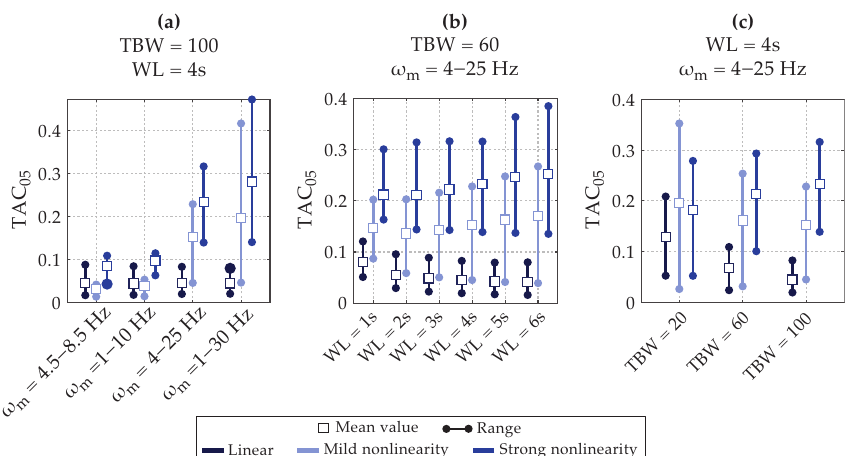
Figure A1. Influence of three hyper-parameters in the derivation of TAC (wavelet time-bandwidth parameter of the Morse wavelet, window length and frequency bandwidth) on the TAC value for five earthquake signals with respectively linear, mildly nonlinear and strongly nonlinear behavior.